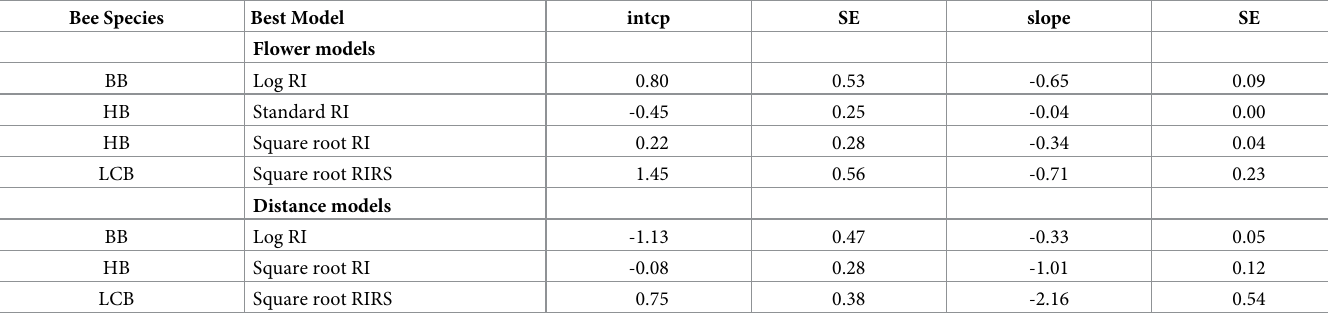
the model presented in Table 2. The standard deviation associated with the random intercept was 0.82. In all cases, the probability of getting GR seeds in a pod decreased as more flowers were visited in succession by a bee (Fig 2C), or longer cumulative distances were traveled (Fig 2D). Leafcutting bee models We obtained 27 foraging bouts and 202 observations for leafcutting bees. The square root model with random slope and random intercept best explained the logit of the probability of getting GR seeds in a pod, for both successive flowers and for cumulative distance (Table 1). Table 2. Fixed effect estimates for the best flower and distance model(s) for bumble bees (BB), honey bees (HB), or leafcutting bees (LCB). Bee Species